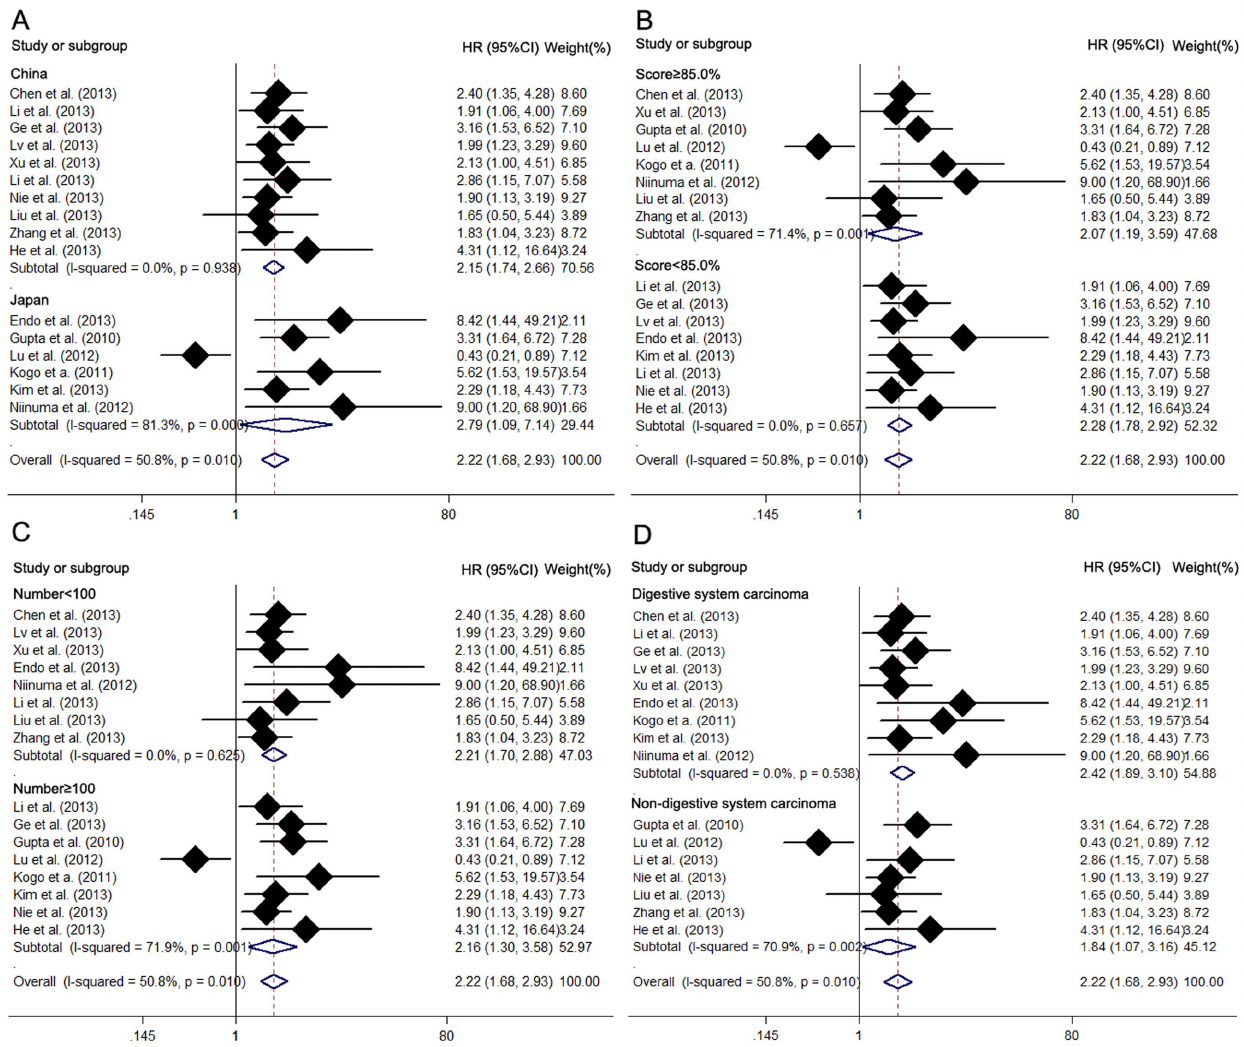
Figure 2. Meta analysis of the pooled HRs of OS of different types of cancer with increased HOTAIR expression. (A) Subgroup analysis of HRs of OS by factor of region. (B) Subgroup analysis of HRs of OS by factor of score. (C) Subgroup analysis of HRs of OS by factor of sample size. (D) Subgroup analysis of HRs of OS by factor of type of cancer.